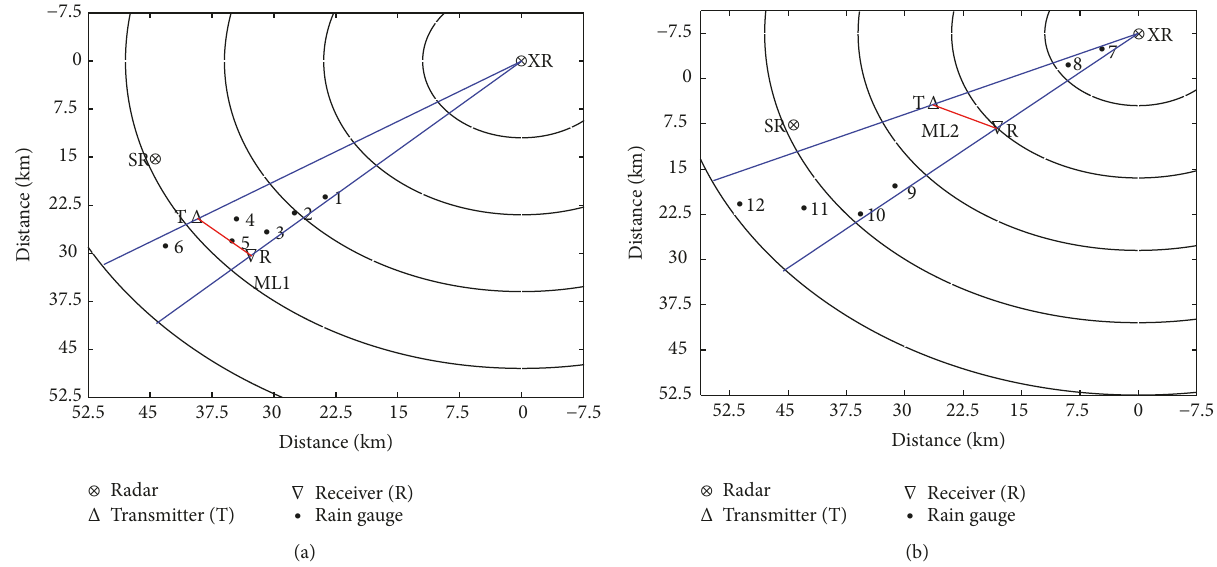
Figure 3: Diagram of the experiment area for (a) case I and (b) case II. The locations of the X-band radar, S-band radar, 2 microwave links, and 12 rain gauges are indicated. The circles correspond to X-band radar ranges of 12, 24, 36, 48, and 60 km, respectively. Table 2: Main characteristic values of the microwave links.